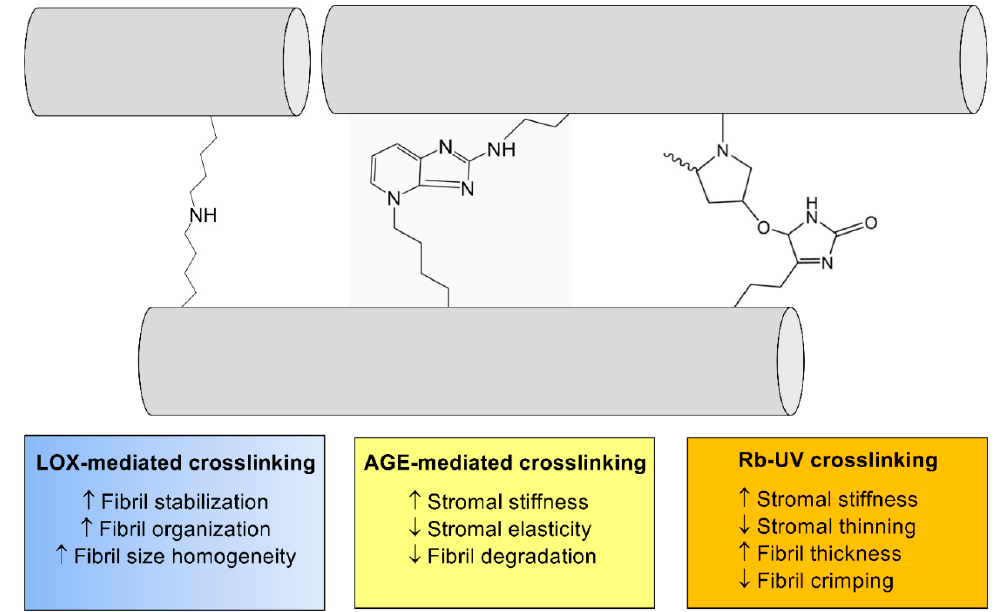
Figure 6. The general effects of crosslinking on collagen structure within the corneal stroma. Enzymatic crosslinking (lysyl oxidase (LOX)-mediated (blue)) and non-enzymatic crosslinking (AGE-mediated (yellow) and riboflavin (Rb)/UV-mediated (orange)) lead to significant effects on ECM structure via modifications to collagen fibril (gray) thickness and organization.